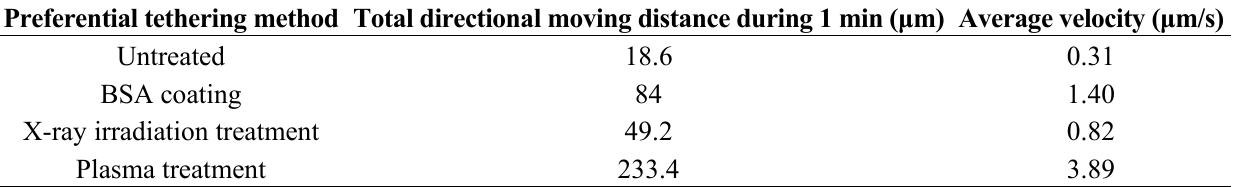
Table 1. Directional moving distances and average velocities of microactuators.